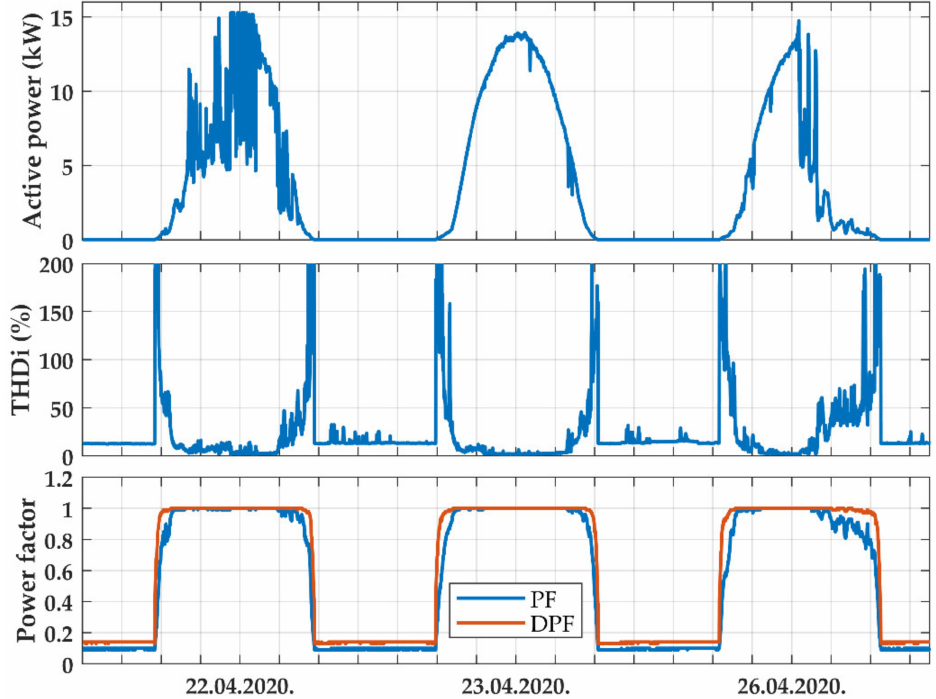
Figure 2. PV system production (active power) followed by changes in THD I factor, power factor (PF), and displacement power factor (DPF) for different weather